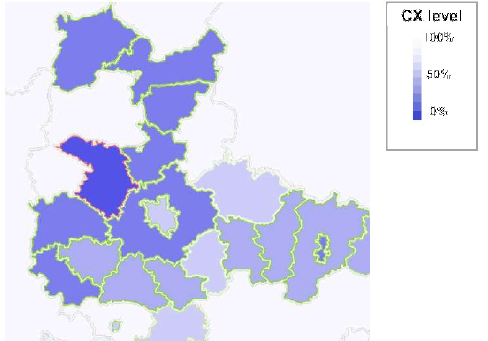
Figure 8. Example CX aggregation as calculated for a specific geographical